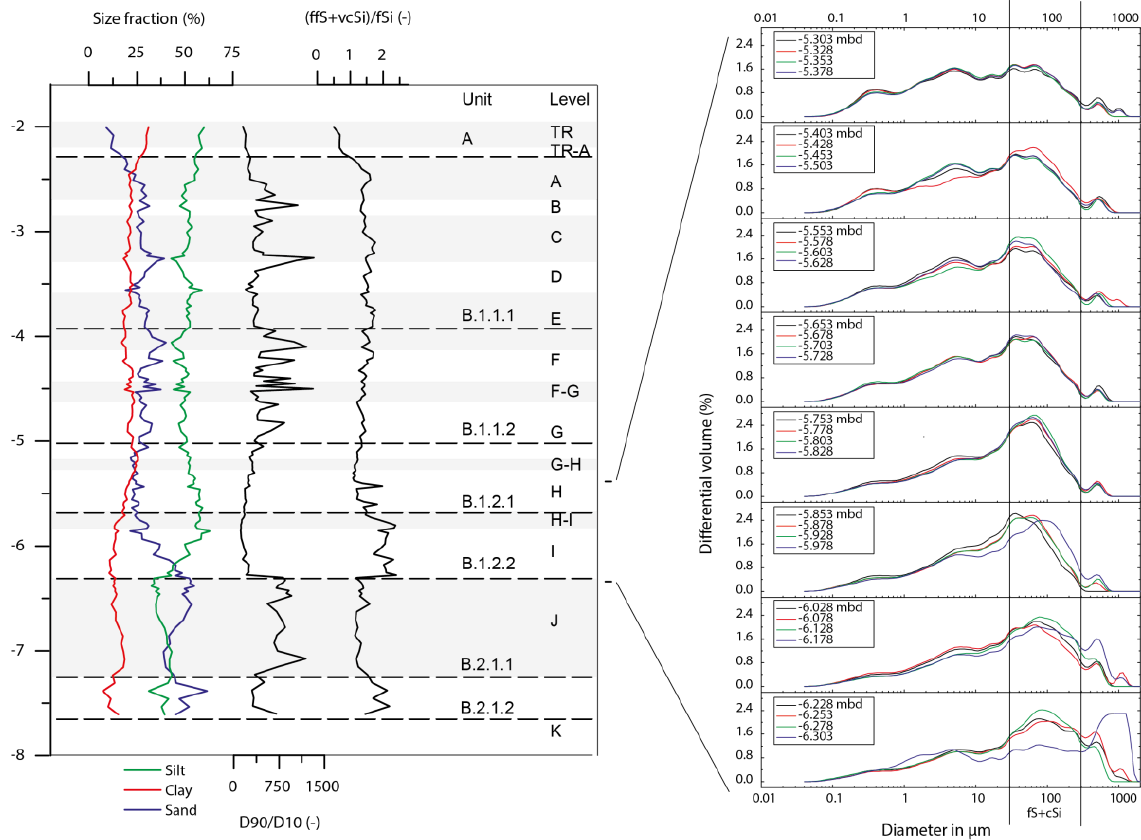
Figure 5. Granulometrical parameters of the fine fraction ( < 2mm in diameter) and frequency distributions for samples from the MP/UP transition of the north profile at square E 0 at Arbreda.